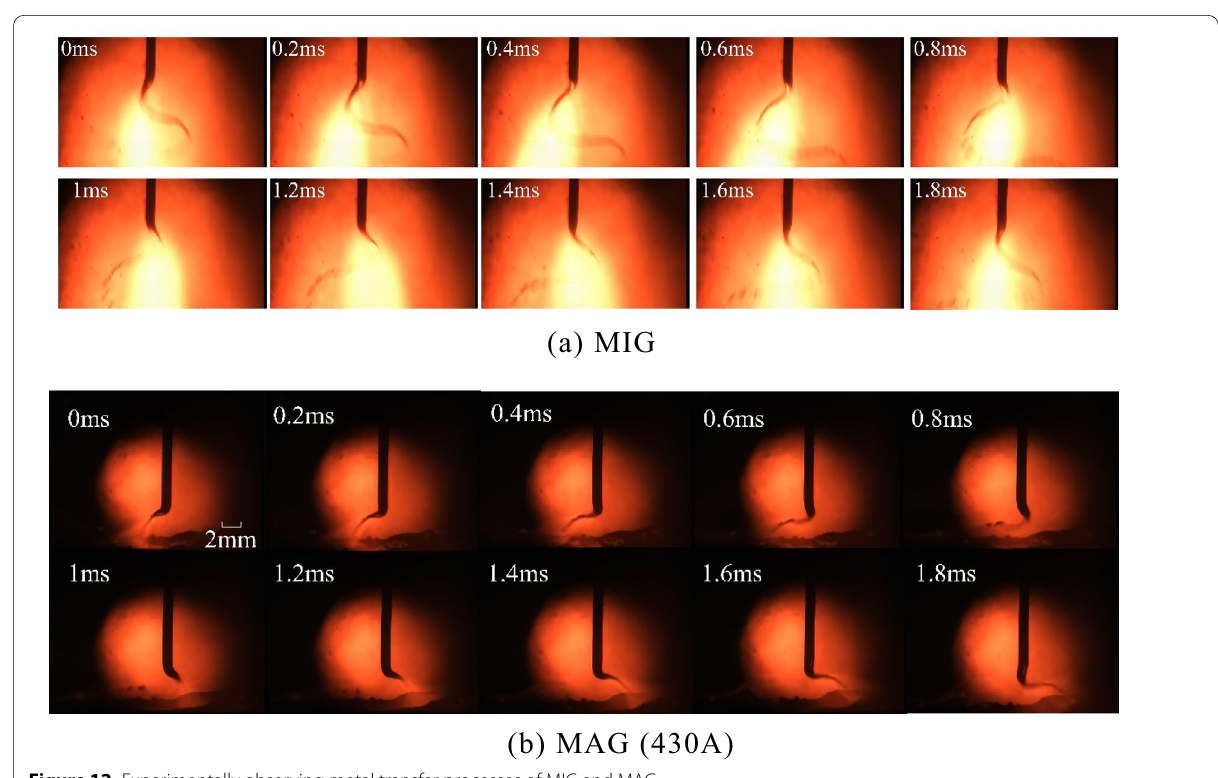
Figure 12 Experimentally observing metal transfer processes of MIG and MAG